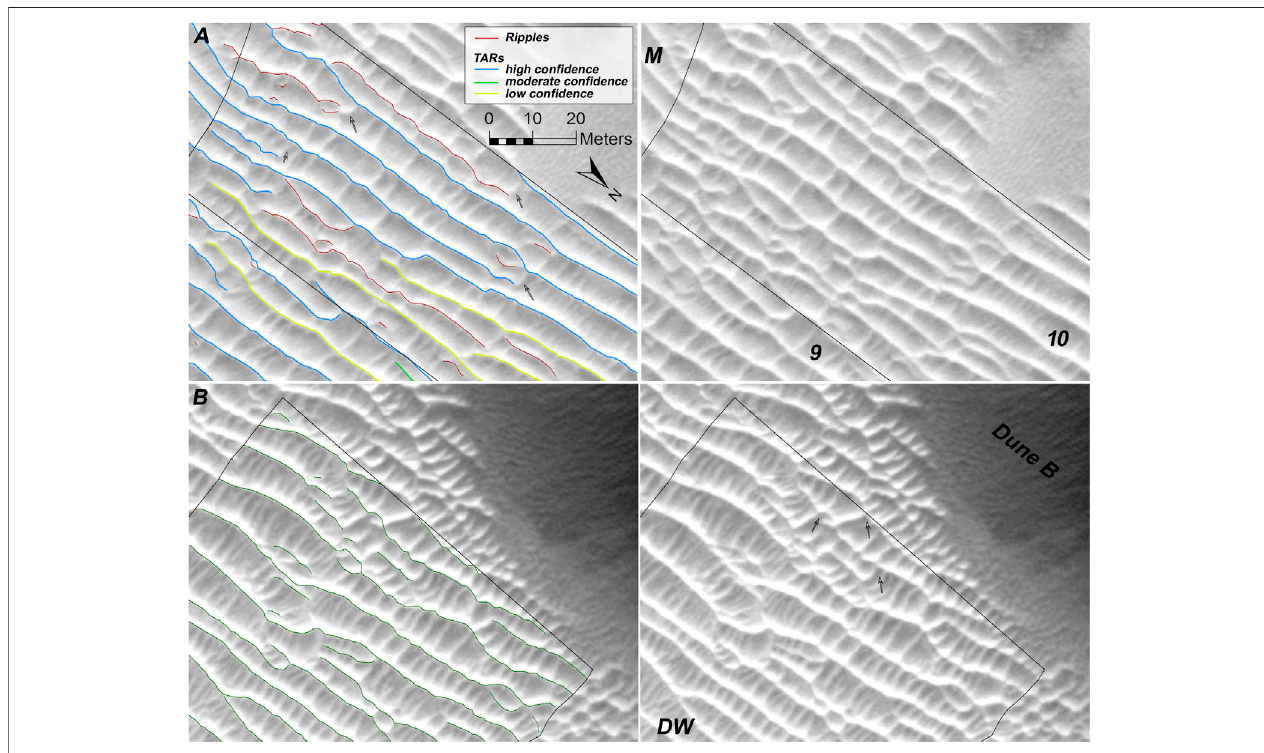
FIGURE 9 | Ripples and TARs shown with and without mapped crestlines at (A) the upwind edge of the mapped Dune A wake and (B) along-slope ripples in fl uencingTARsdownwindofDuneB(orthorecti fi edHiRISEimageESP_044722_2570).Numberscorrespondwithwakesegments,thematureregionislabeled M ,the downwind region is labeled DW. Arrows indicate along-slope ripples that connect the larger bedforms at a defect in the pattern and, where the ASRs are large enough, potentially contributing to defect generation on TAR crestlines.